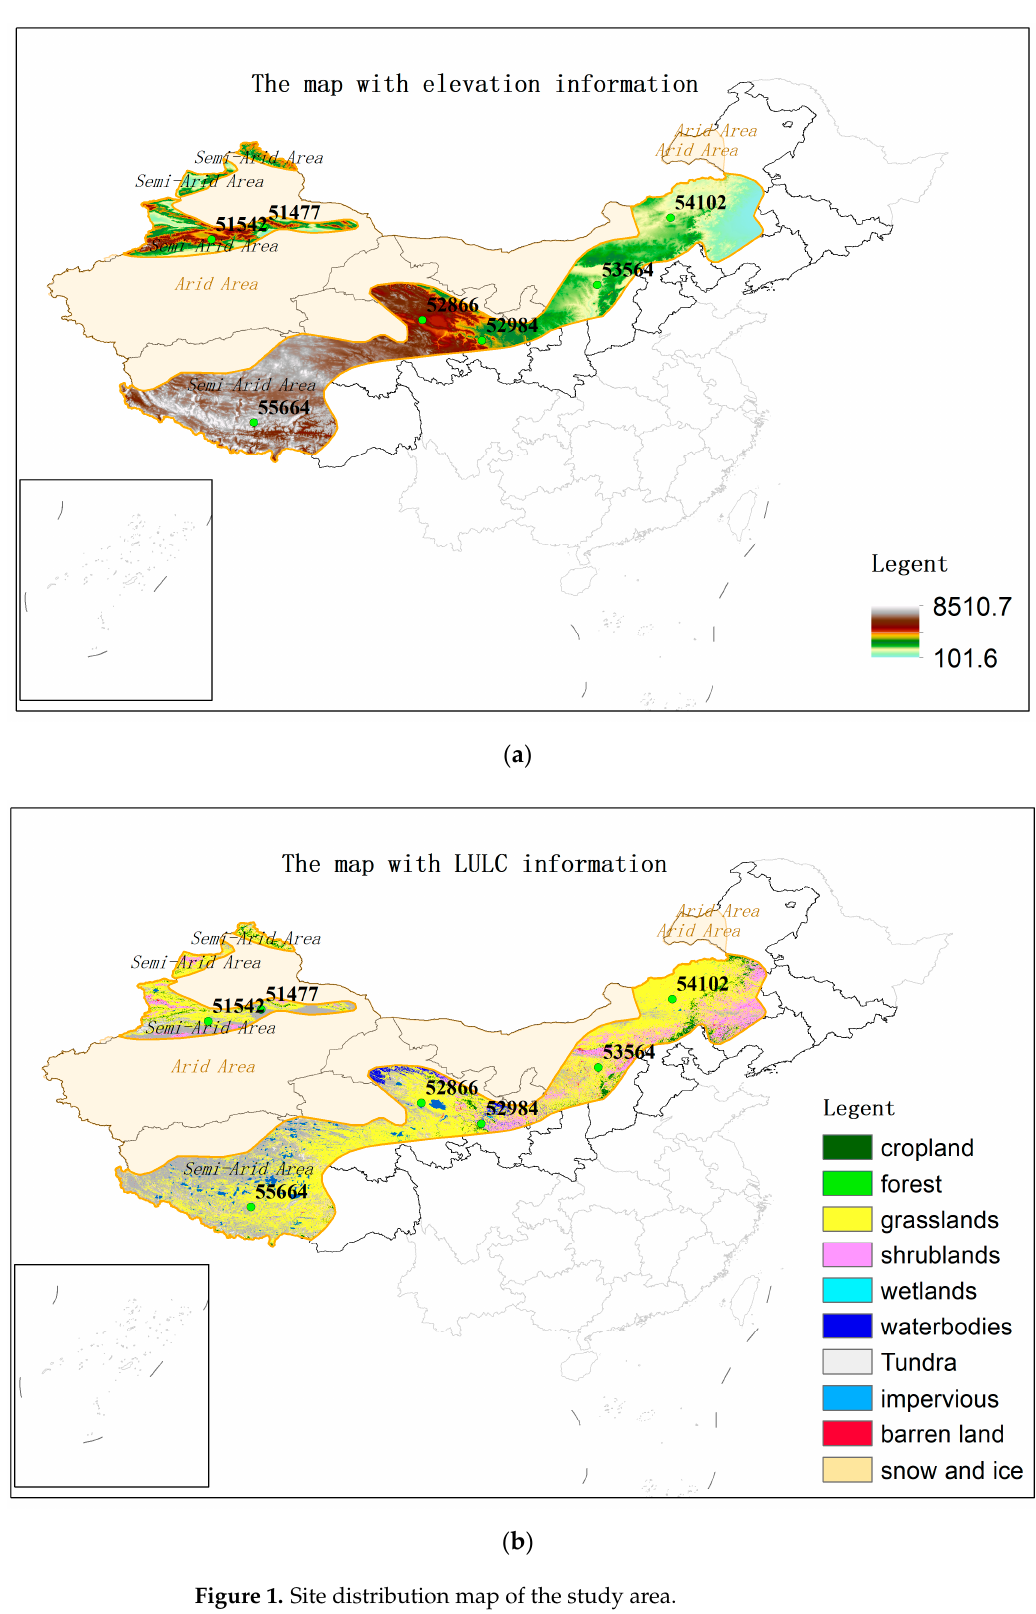
Figure 1. Site distribution map of the study area.